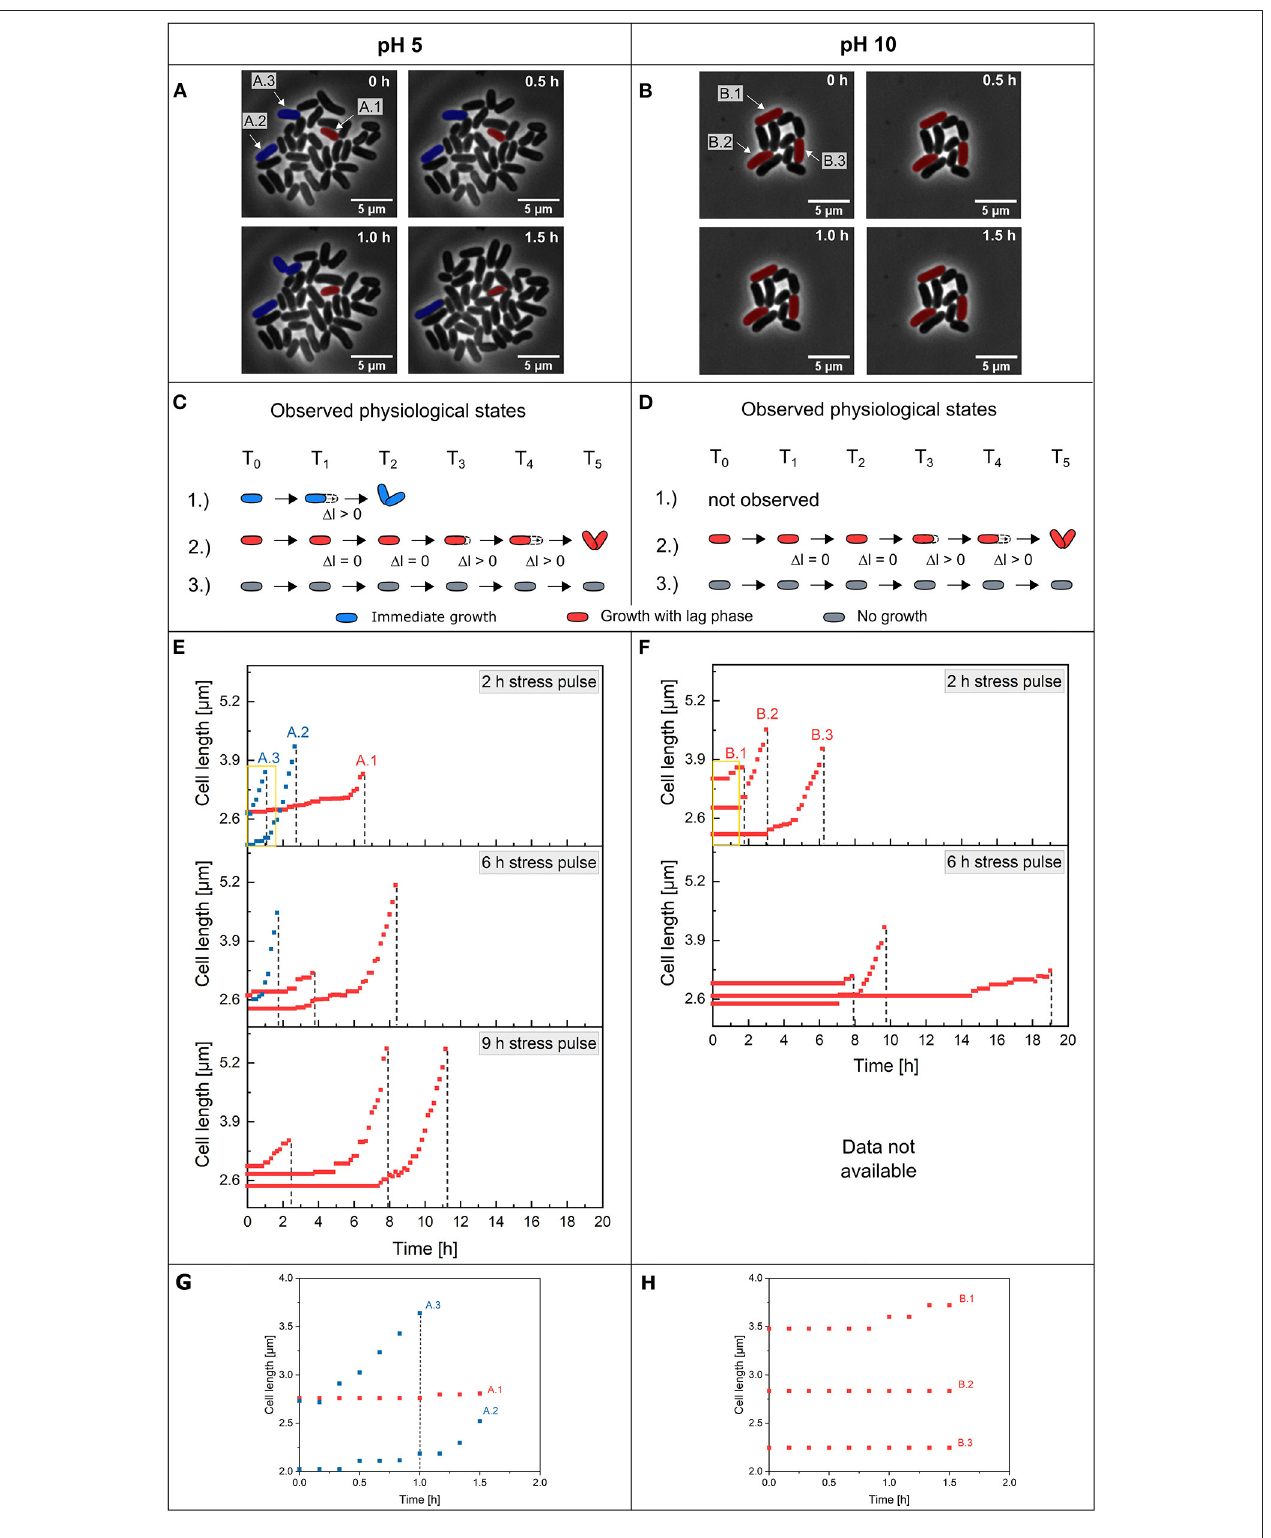
FIGURE 5 | Single-cell adaptation of C. glutamicum after pH stress pulses. Microscope images of growing colonies after a 2h stress pulse of (A) pH 5 and (B) pH 10 at different post-stress time periods. Cells marked blue could be preadapted cells (A.2 and A.3), and red marked cells are non-adapted cells showing a lag